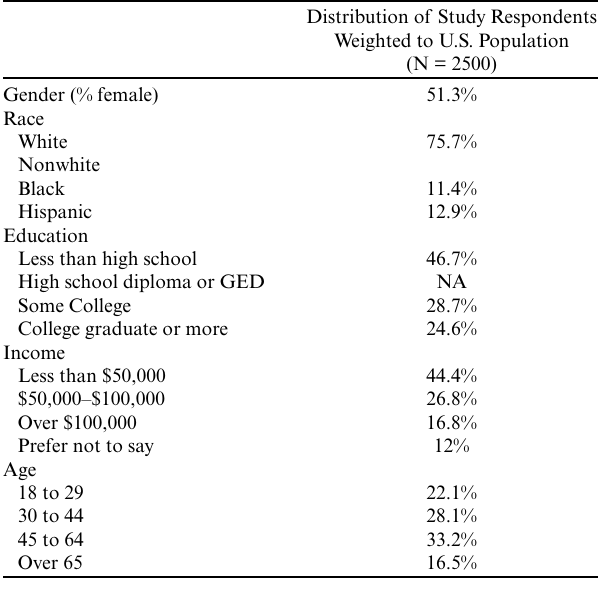
Table 3 . Characteristics of respondents participating in survey 2. N = 2500 U.S. residents. Includes a general population sample of 2000 and oversamples of 250 African Americans and 250 Hispanics to ensure variation across results. The weighted dataset includes two weights within each of the three sample groups (general population and two oversamples), and weighting of the entire sample of 2500 to general U.S. population parameters.